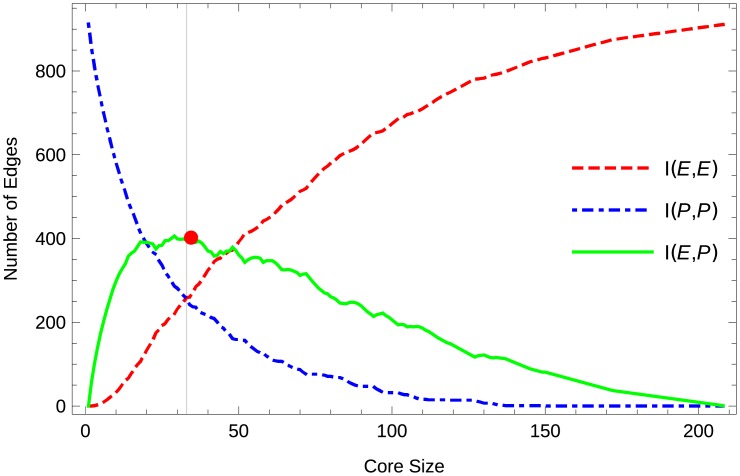
Illustration of the balance point of the Marvel superheroes network.The influence shift diagram, based on adding the 208 nodes to the core in order of their degree πdeg, depicts the influence of the elite and periphery on themselves and each other with growing elite size. The balance point is noted by a grey line. At this point we choose the 32 high degree nodes at the elite. They hold the same power as the rest of the population. The red dot marks the maximum number of crossing edges.